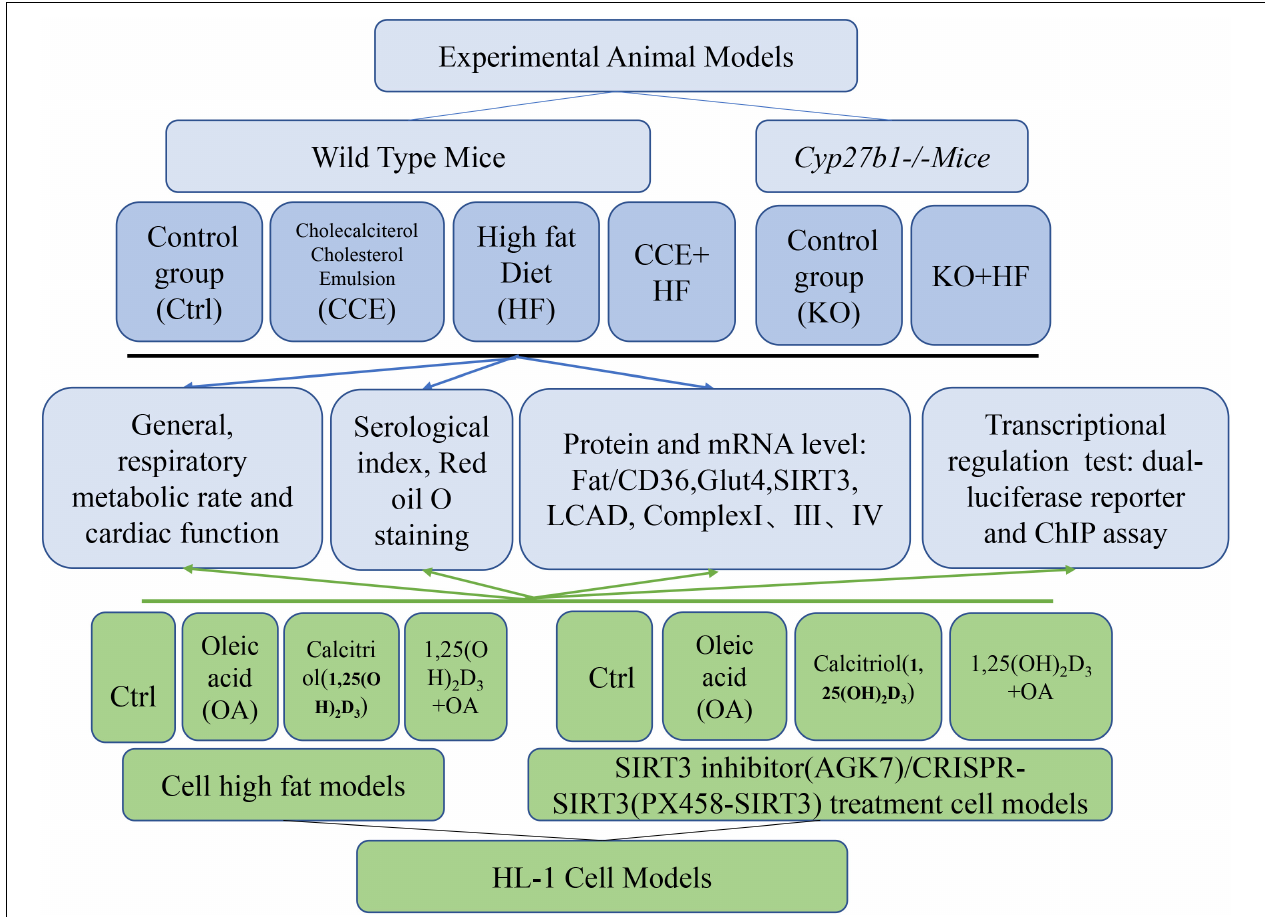
FIGURE 1 | General graphical outline of the experimental design.